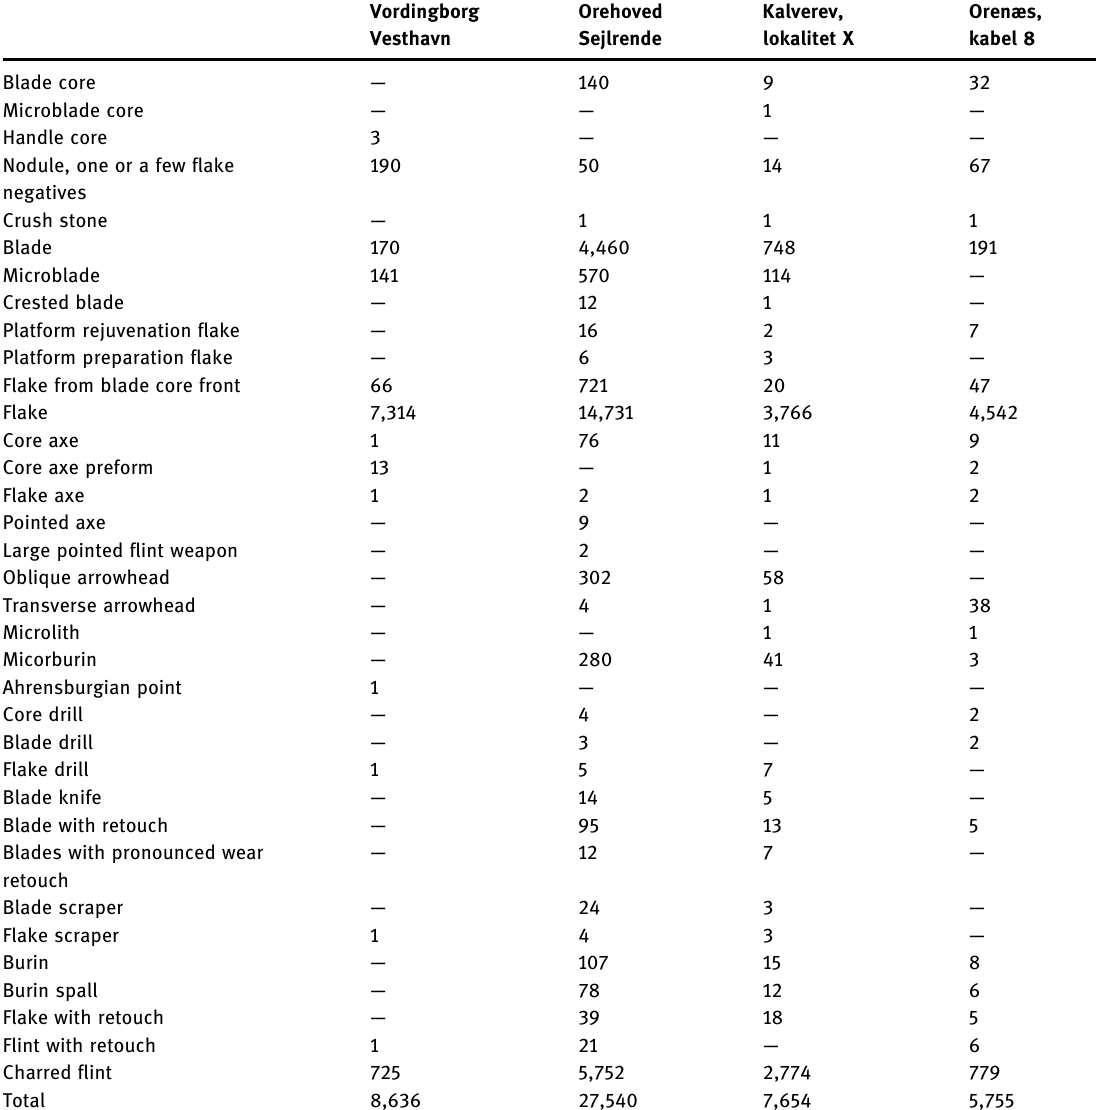
Table 2: Total amount of worked and charred fl int excavated at Vordingborg Vesthavn , Orehoved Sejlrende , Kalverev, Lokalitet X and Orenæs, Kabel